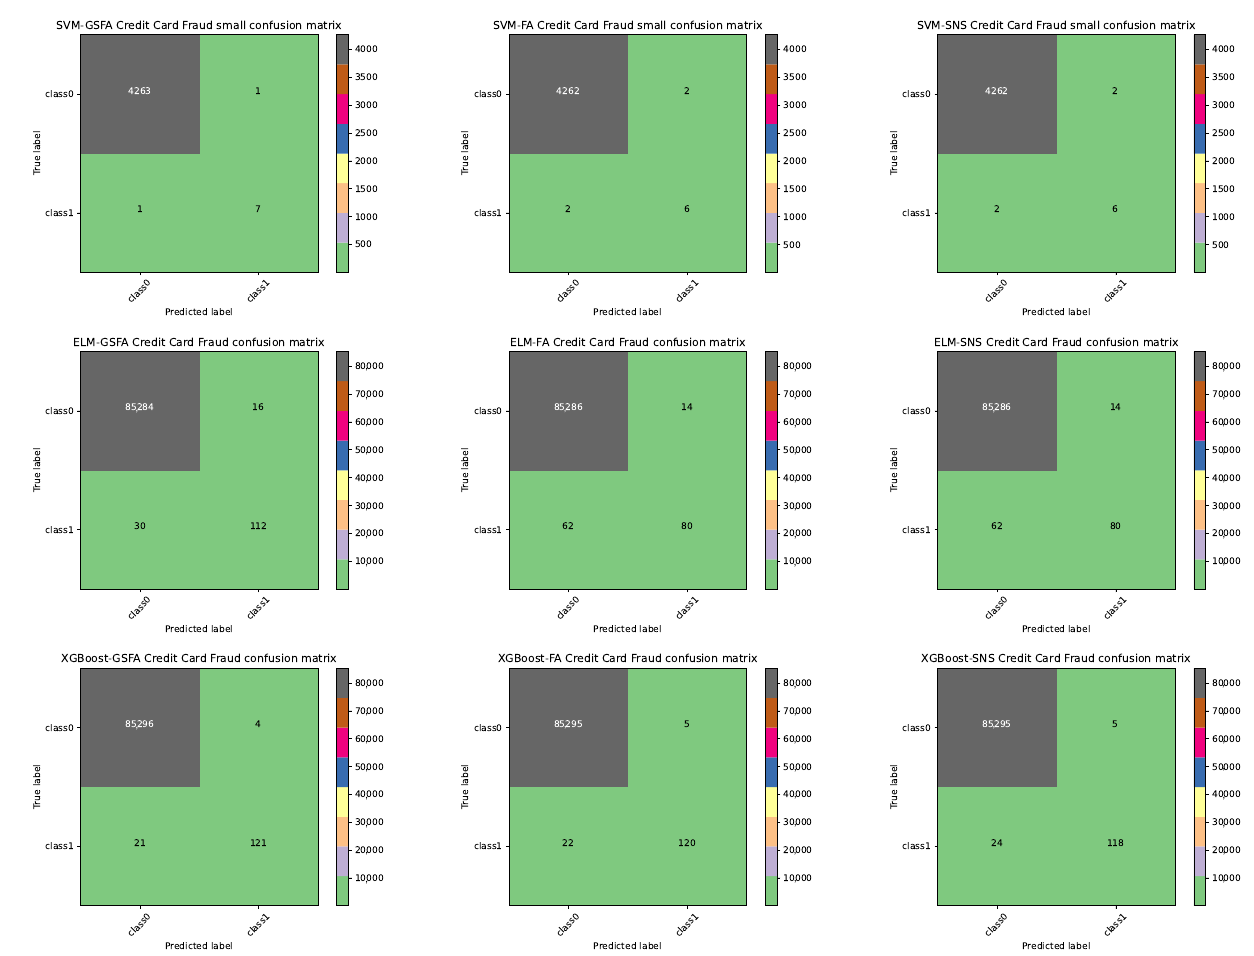
Figure 5. Confusion matrices for SVM, ELM, and XGBoost models tuned by GSFA, FA, and SNS for original credit card fraud